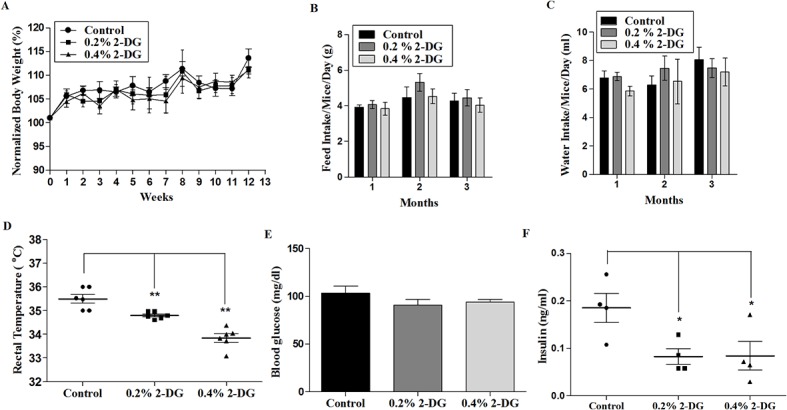
Effect of dietary fed 2-DG on general physiological parameters in mice.(A) Body weight (normalized), (B) Feed intake, (C) Water intake, (D) Body temperature, (E) Blood glucose and (F) Serum insulin levels. Body weight, feed intake, water intake were measured weekly for 3 months of 2-DG feeding, whereas body temperature (anal) was measured at the end of 3 months. Blood glucose and serum insulin levels were analysed at day 60 of the 3 months period. Values presented are means ± SE. *, p < 0.05; **, p < 0.01; ***, p < 0.001